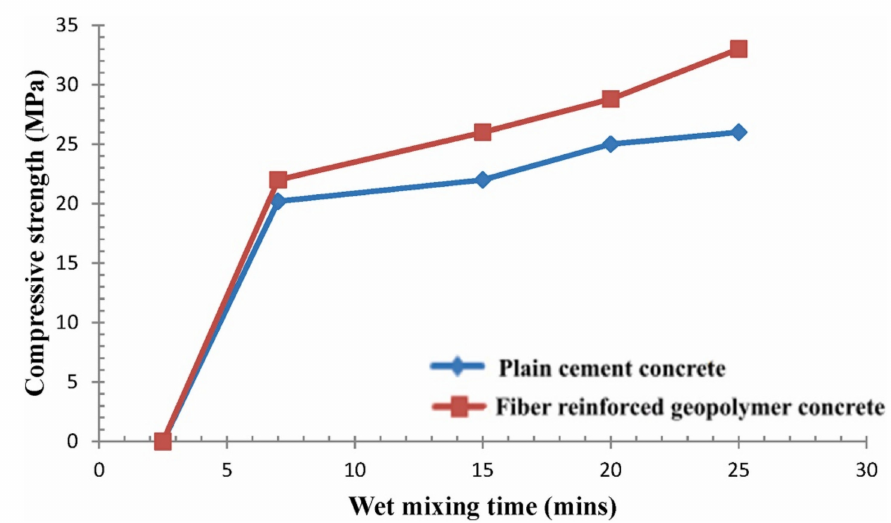
Figure 7. Variation of mixing time on the mechanical compressive strength of traditional and geopolymer concrete